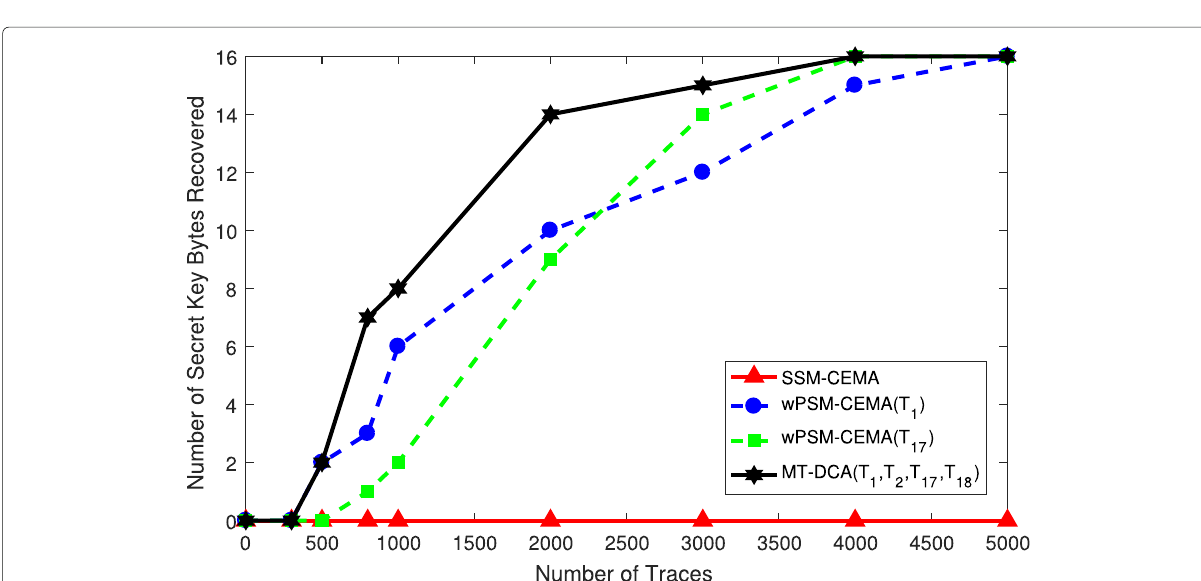
Fig. 12 The experimental results of SSM-CEMA, wPSM-CEMA and MT-DCA in T 32 G - S 1 G encryption